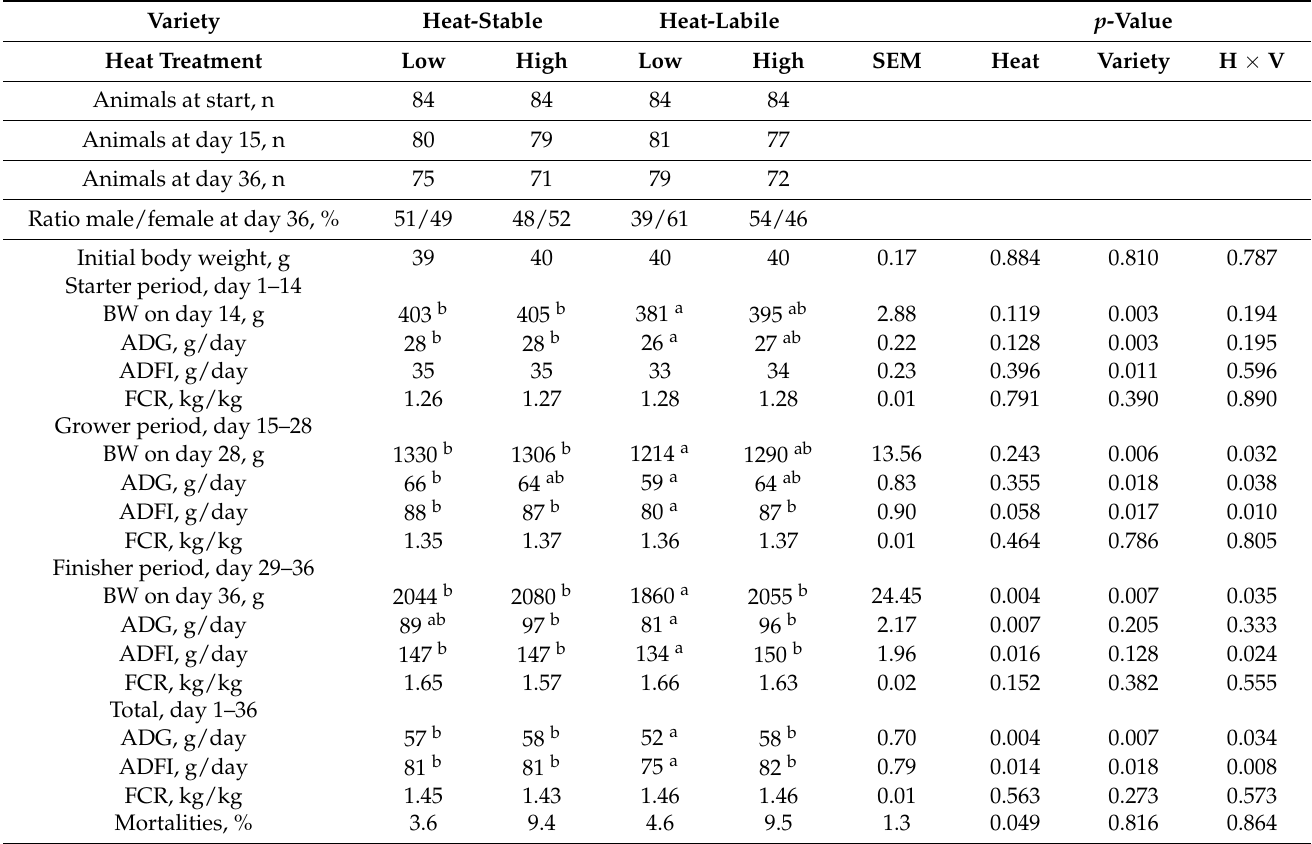
Table 3. Growth performance characteristics of the broiler chickens.